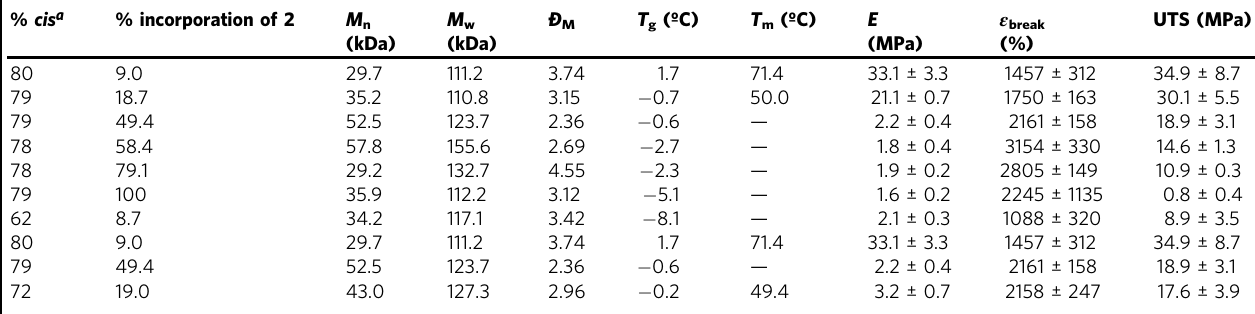
Table 2 SEC, thermal and mechanical characterization of the degradable elastomers synthesized by step-growth polymerization incorporating